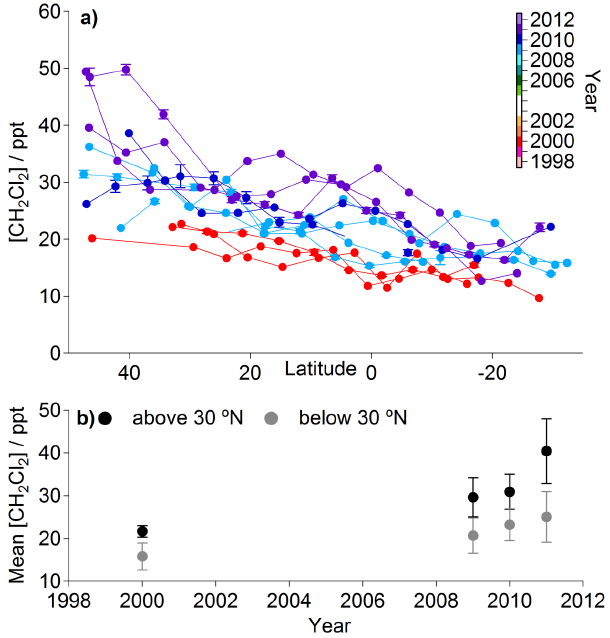
Figure 3. a) Latitudinal distributions of CH 2 Cl 2 observed during flights to South Africa where 1221 Figure 3. (a) Latitudinal distributions of CH 2 Cl 2 observed during colour = year (see inset colour bar, colour scale is consistent with Figs. 2, 4 and 6). Where multiple 1222 flights to South Africa where colour = year (see inset colour bar, measurements of the same sample have been made 1σ error bars are given, see Section 2. b) Annual 1223 colour scale is consistent with Figs. 2, 4 and 6). Where multiple tropospheric values (see Fig. 2) with 1σ error bars. These average values have been split into above 1224 and below 30 °N. 1225 measurements of the same sample have been made 1 σ error bars are given, see Sect. 2. (b) Annual tropospheric values (see Fig. 2) with 1 σ error bars. These average values have been split into above and below 30 ◦